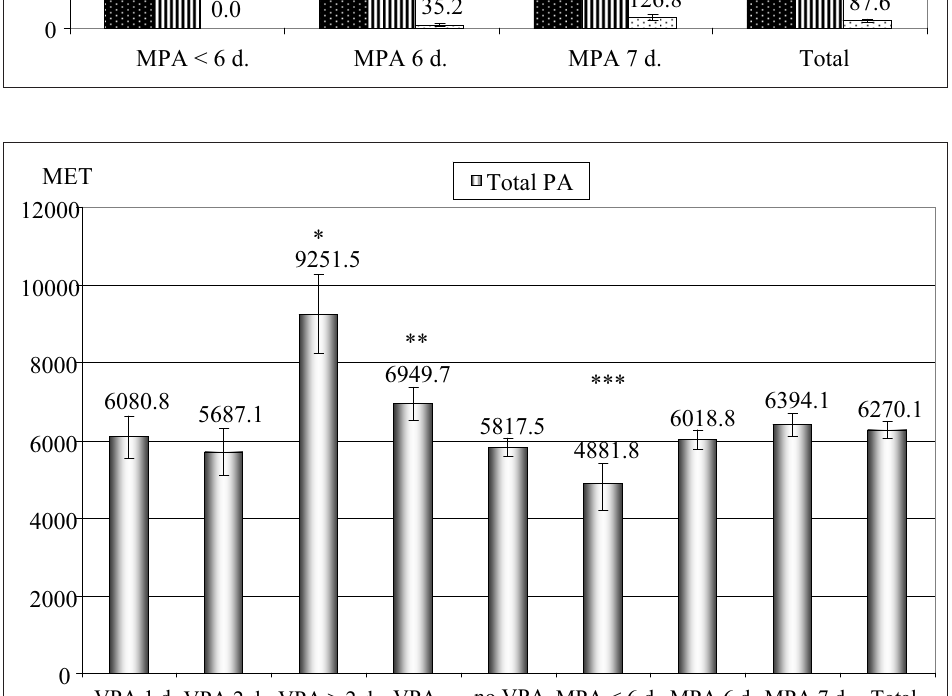
Figure 4. The total amount of weekly physical activity of the adolescent boys